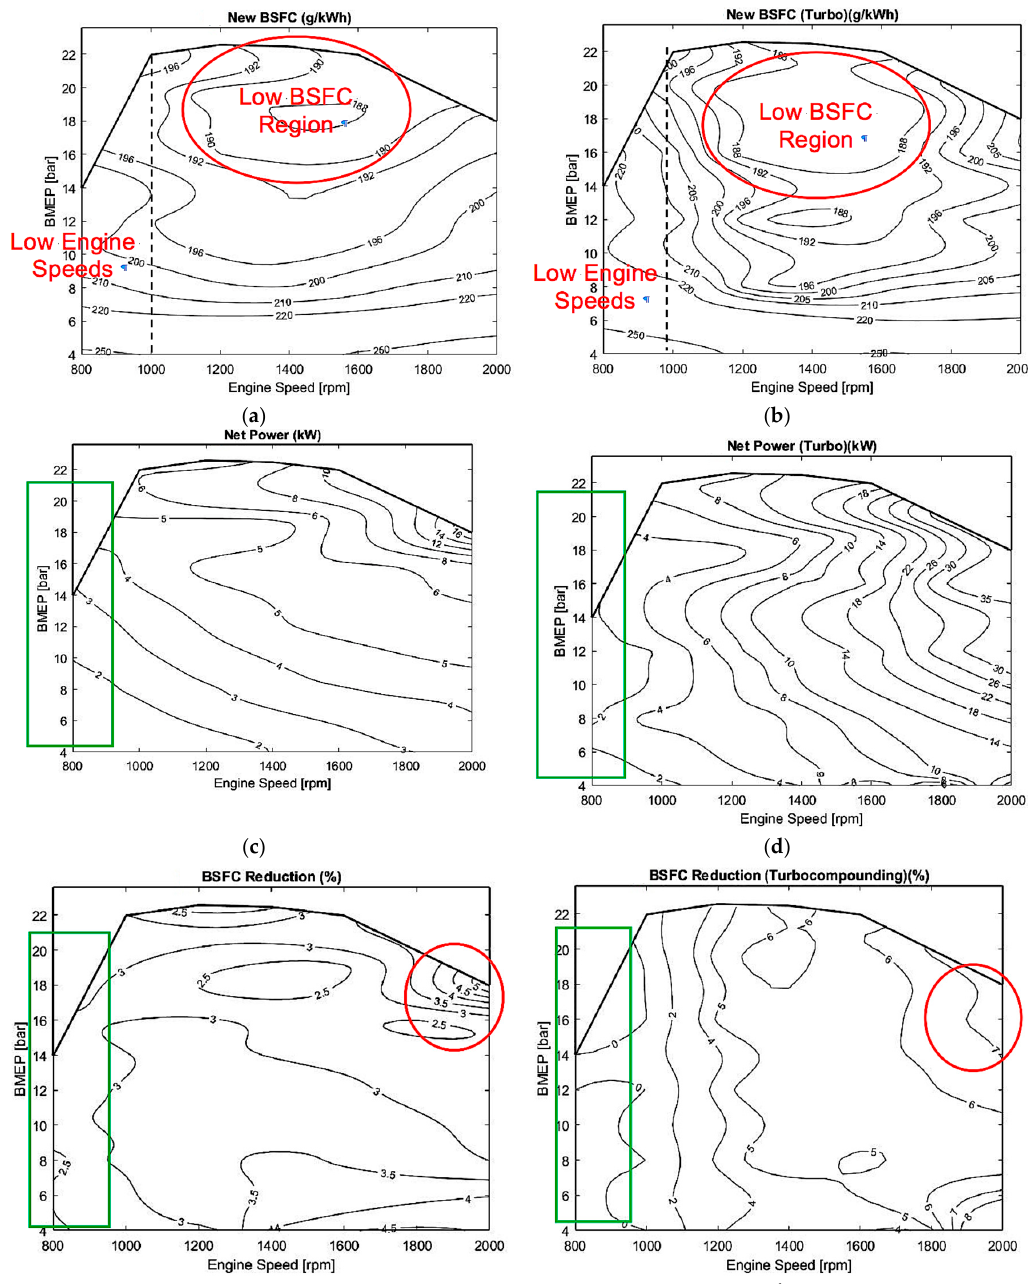
Figure 6. Overall comparison of engine performance with ORC and turbocompounding: ( a ) New BSFC of engine with ORC based on BMEP map; ( b ) New BSFC of engine with turbocompounding system based on BMEP map; ( c ) Net power produced by turbine in ORC heat recovery system based on BMEP map; ( d ) Net power produced by turbine in turbocompounding system based on BMEP map; ( e ) Amount of BSFC reduction in engine with ORC system based on BMEP map; ( f ) Amount of BSFC reduction in engine with turbocompounding system based on BMEP map.